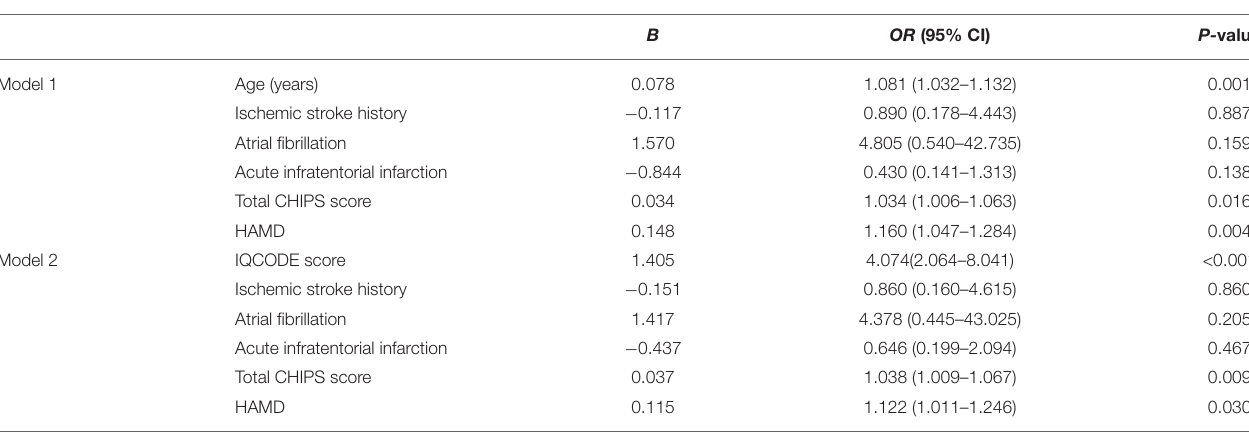
TABLE 2 | Multivariate logistic regression of risk factors for PSCI.